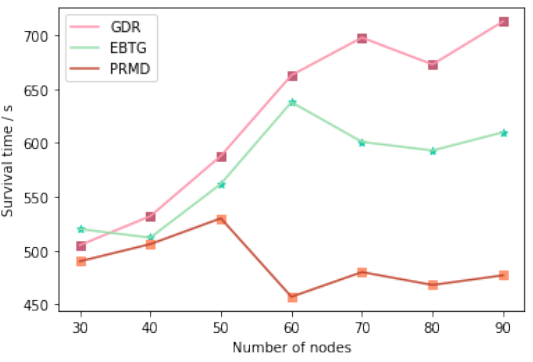
Figure 11. Survival time